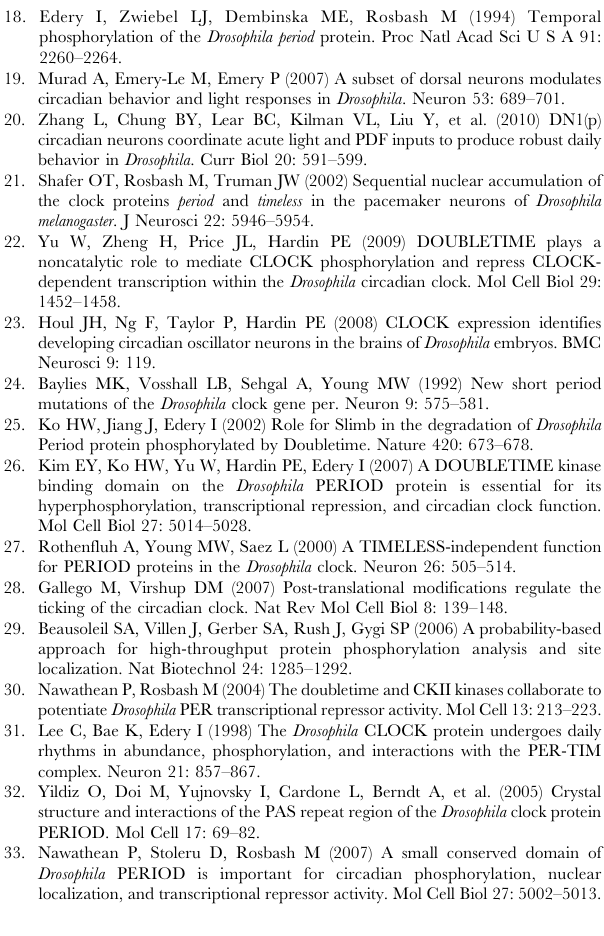
Table S1 Primers used in this study to generate mutant PER transgenes. The following primers and mutagenesis kits were used to mutate the indicated regions/residues within the Per13.2 vector backbone. See materials and methods for additional